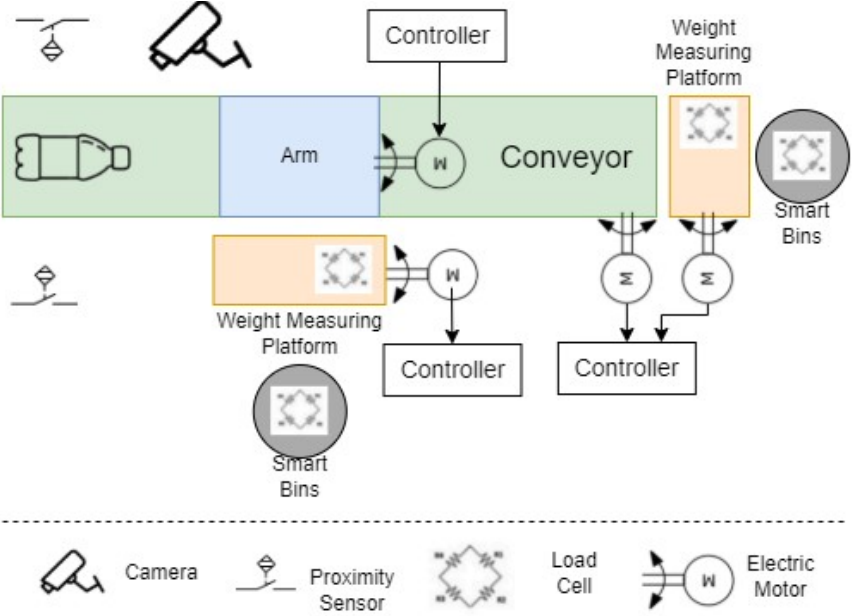
Figure 4. Sensor setup of the proposed Reverse Vending Machine.